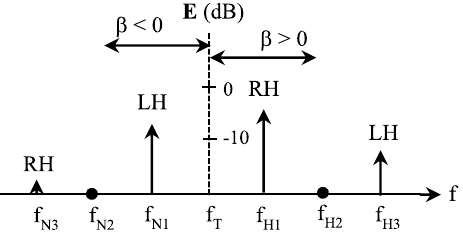
Fig. 18. Broadside radiation E BrdSQ j n ¼ E for square model-C.